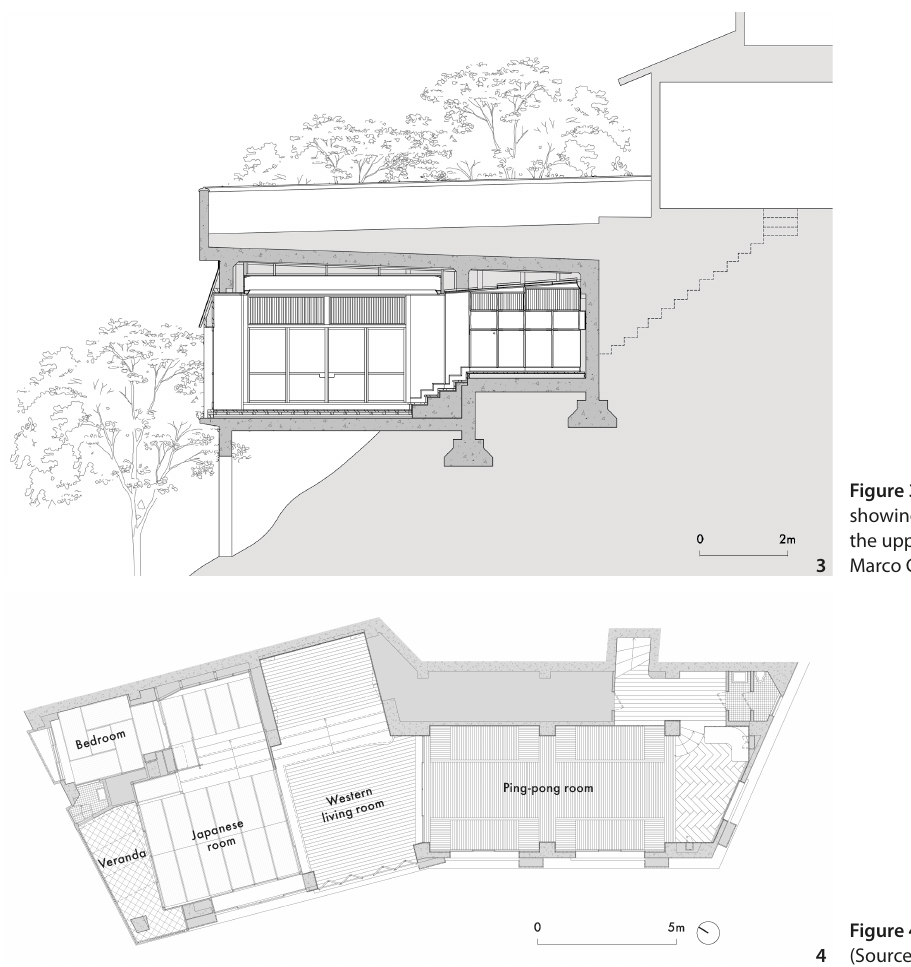
Figure 4 Floor plan of Taut’s intervention (Source: Marco